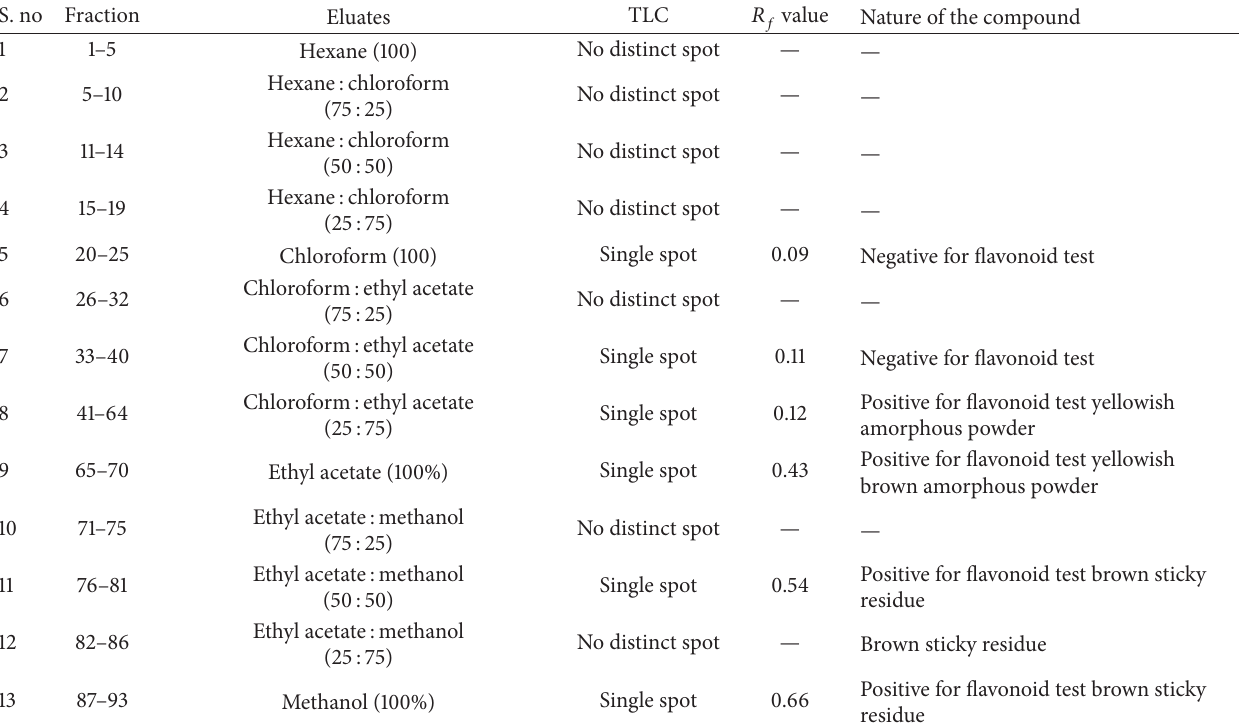
Table 1: Isolation of total flavonoid fraction from the ethanol extract of Cissus quadrangularis .